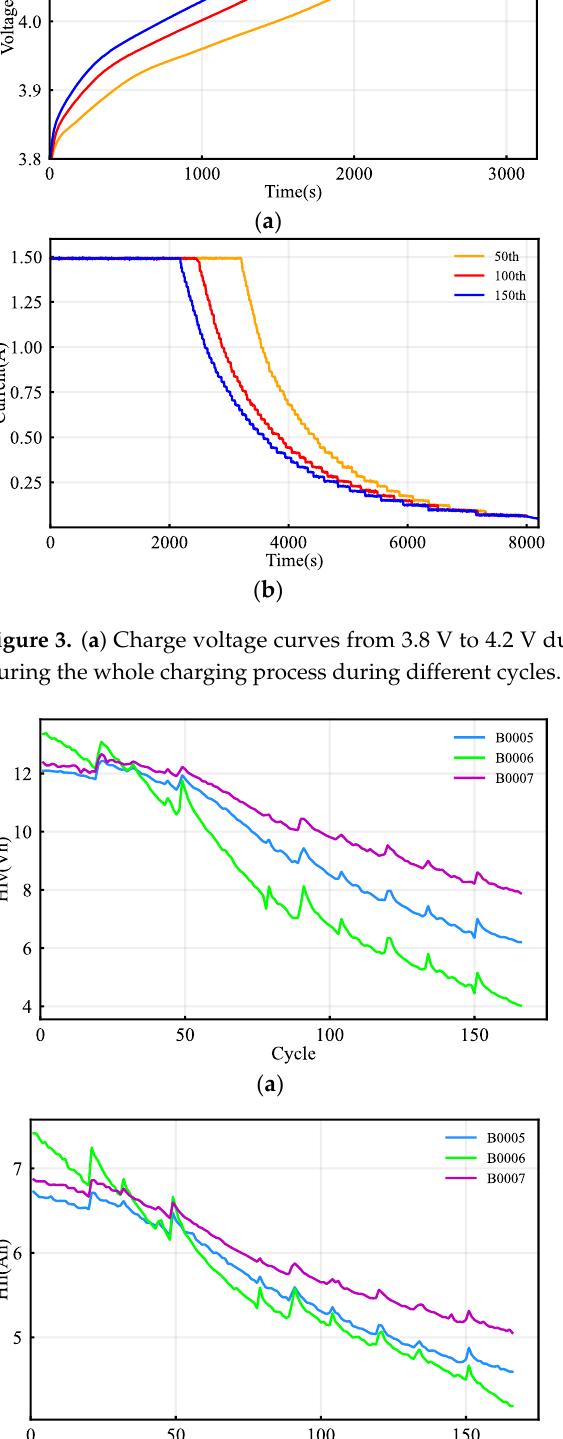
( b ) Figure 5. ( a ) Charge voltage curves from 3.8 V to 4.2 V during three different cycles for the CS2-35 battery; ( b ) the curves of the values of the health indicator ( HI v ) versus the cycle number for the CALCE battery dataset. 3. LSTM-RNN Algorithm Due to their “memory” characteristics, RNNs are suitable for this type of time -series data estimation [33]. However, conventional RNNs have issues in learning long-term de- pendencies where the gradients may either vanish or explode during backpropagation [34]. To address this problem, an LSTM-RNN was proposed to capture long-term depend- encies within the sequence by remembering information over long periods [35]. Therefore, this paper utilizes an LSTM-RNN to estimate the SOH of lithium-ion batteries. Figure 6 schematically illustrates the network architecture of LSTM-RNN, which can work as a nonlinear dynamic system by mapping input vectors to output sequences. The LSTM cell is equipped with a memory cell c k , which is the key part of the structure and stores the long-term dependencies. In addition, the input, output, and forget gates are distinctive features of the LSTM-RNN and can regulate the information flow. Each gate is a sigmoid unit (σ) that is activated from the hidden layer at the last time step h k − 1 and from